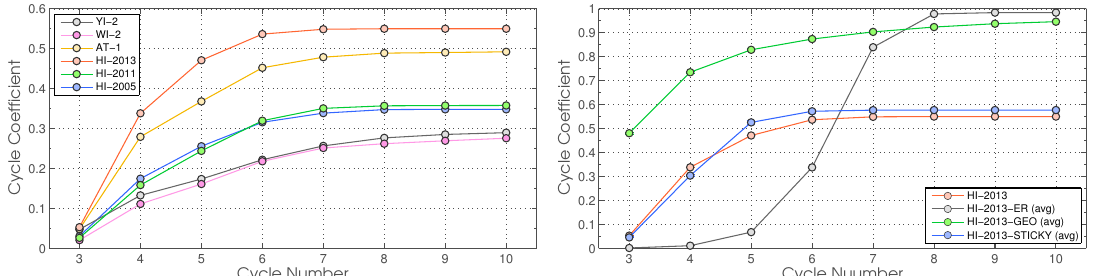
Figure 7: Left panel — Cycle coefficients for PPI networks. Numbers on the horizontal axis correspond to cycle size, i.e., 3 stands for the cycle coefficient for 3-node cycles, C 3 (this is the clustering coefficient), 4 for the cycle coefficient for 4-node cycles etc. The vertical axis gives the value of the i th cycle coefficient of a network, for i = 1 , 2 , 3 , . . . , 10 . Right panel — Cycle coefficients for HI-2013 and model